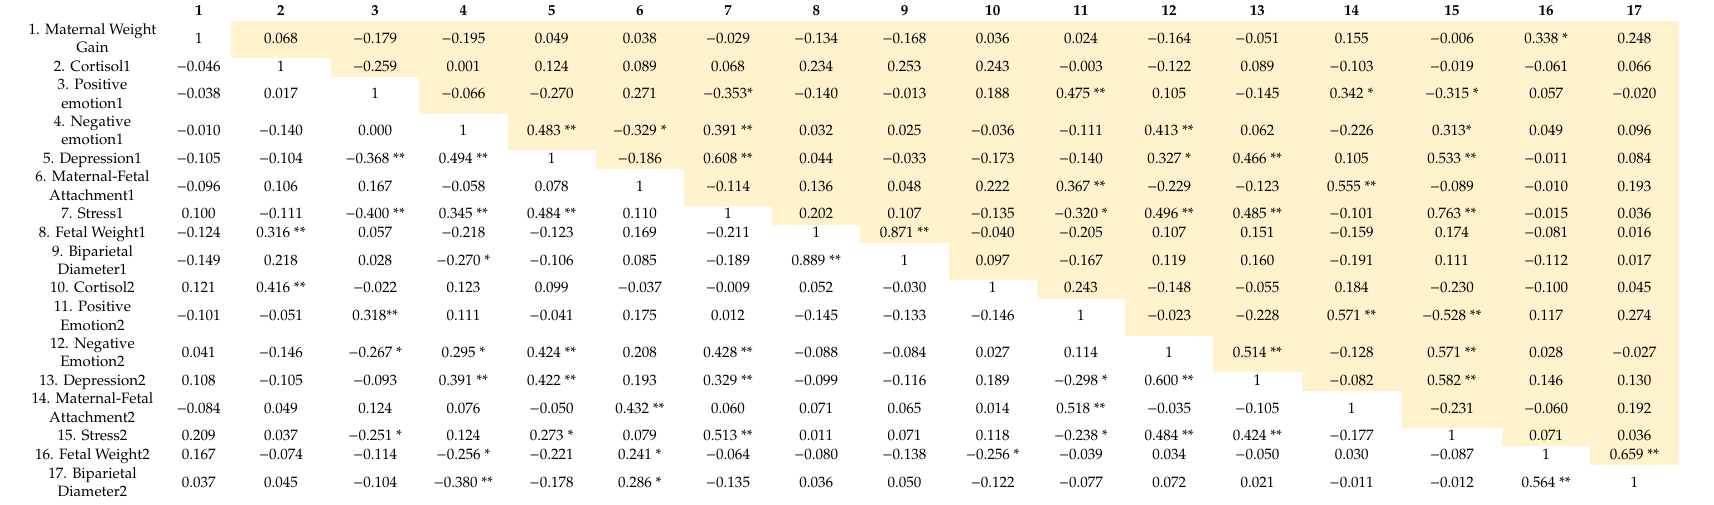
Table 3. Correlations among maternal emotional status and fetal